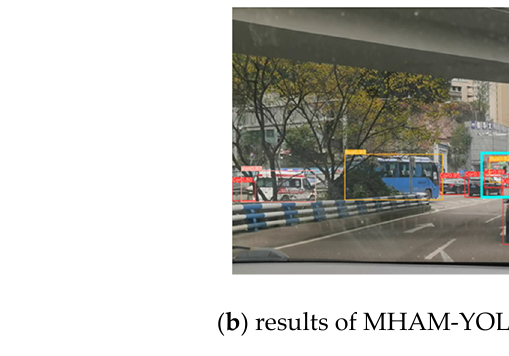
Figure 11. Comparison of the detection effect of dense continuous occlusion of vehicles.